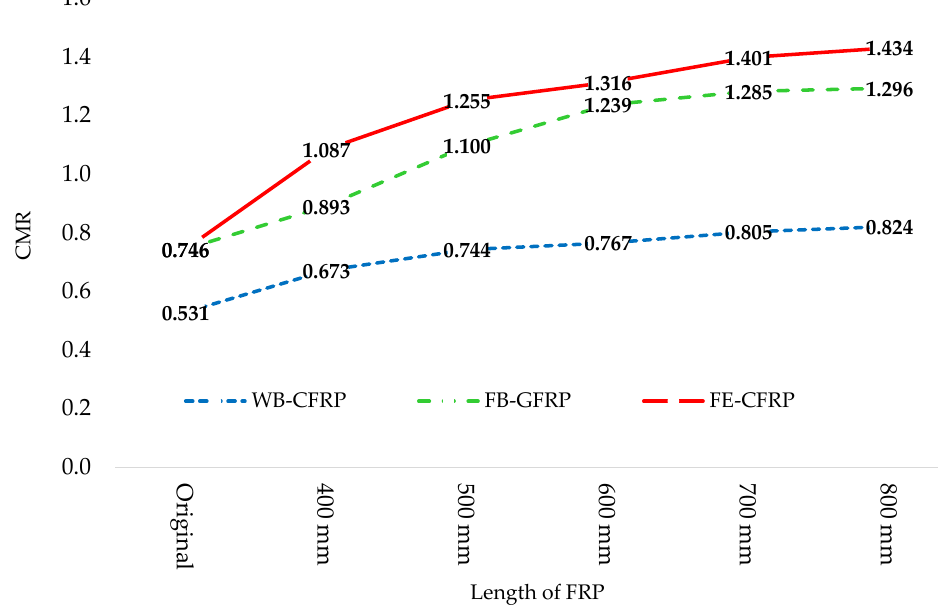
Figure 18. The enhancement of CMR in the retrofitted frames.